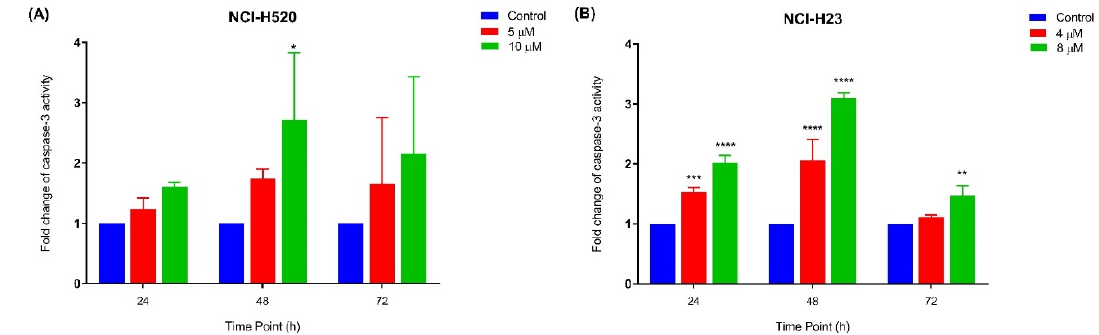
Figure 6. Relative caspase-3 activity in ( A ) NCI-H520 and ( B ) NCI-H23 cells treated with MS13 at different time points. Experiments were performed in triplicates and results compared between three independent experiments. Results are expressed as the ratio of means of caspase-3 activity of treated samples over untreated samples and comparison between data sets performed using ANOVA. Asterisks indicate statistically significant ( * for p < 0.05, ** for p < 0.01, *** for p < 0.001 and **** for p < 0.0001) differences between data sets for each treatment dose.